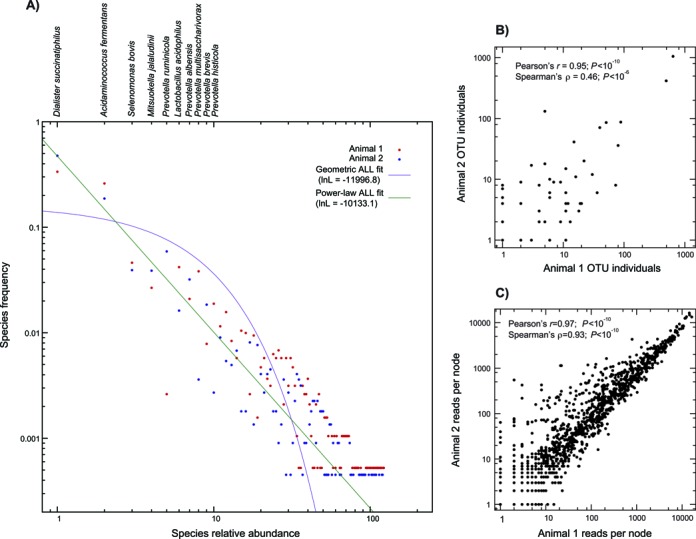
Taxonomic and functional analyses of the ruminal metagenomes of two bovine individuals. (A) Distribution of the 122 OTUs found, with models of the abundance distributions of those OTUs. On the x-axis is the rank abundance of each OTU for animal 1 (red) and animal 2 (blue): the most abundant OTU has rank 1 and so forth. On the y-axis is the proportion of that animal's total microbial individuals that that OTU comprises. We fit two statistical distributions to these data: a discrete power-law (green) and a geometric (purple; see ‘Materials and Methods’ section). Taxon names for the first 10 OTUs are shown above the panel. (B) Correlation between OTU abundance for animal 1 (x-axis) and animal 2 (y-axis). Note the log scale in both cases. (C) Correlation of the number of mapped read pairs for each metabolic reaction (node) for the two animals. Axes are as for B and are also shown in log-scale.